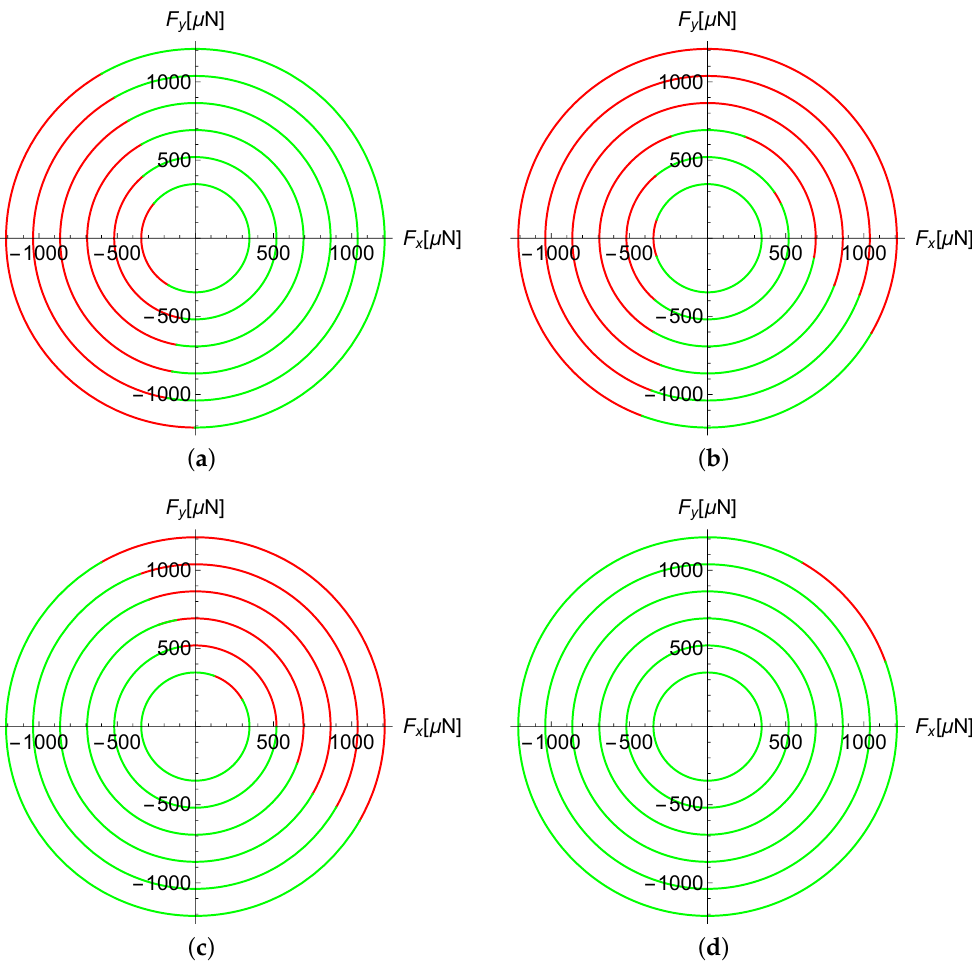
Figure 6. Force vs. contact diagrams: contact charts for the joint C 1 ( a ); C 2 ( b ); C 3 ( c ); and C 4 ( d ),